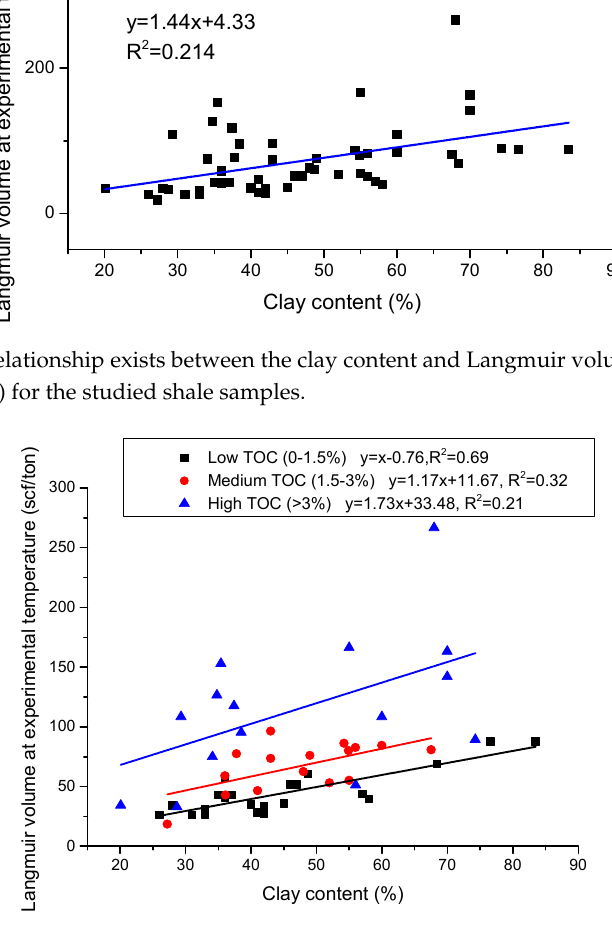
Figure 2. A weak relationship exists between the clay content and Langmuir volume at experimental temperature (30 °C) for the studied shale samples.